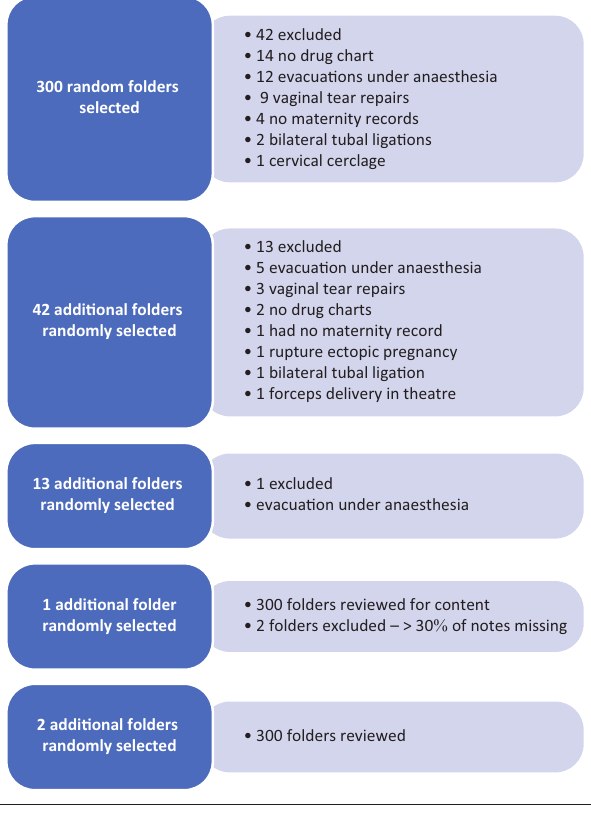
FIGURE 1: Flow chart of folder selection process to obtain 300 random